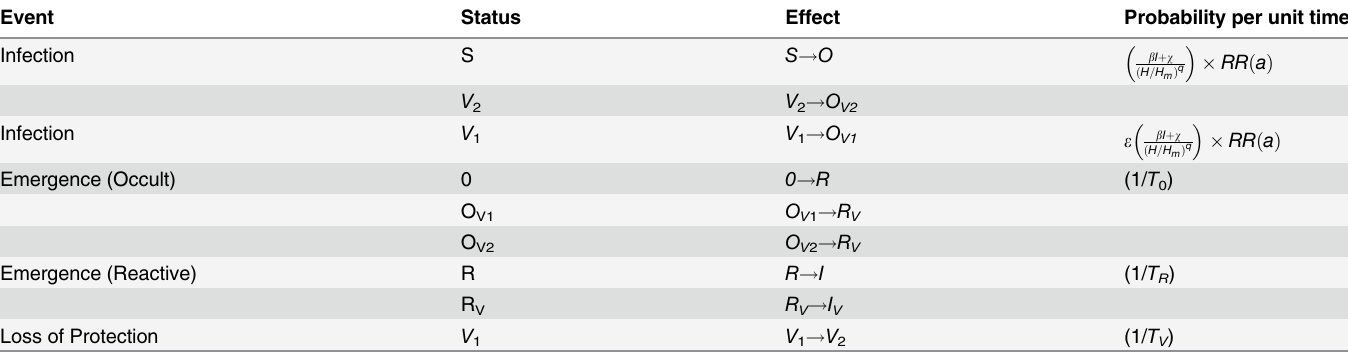
Table 7. Markov events for SORI(V) stochastic transmission